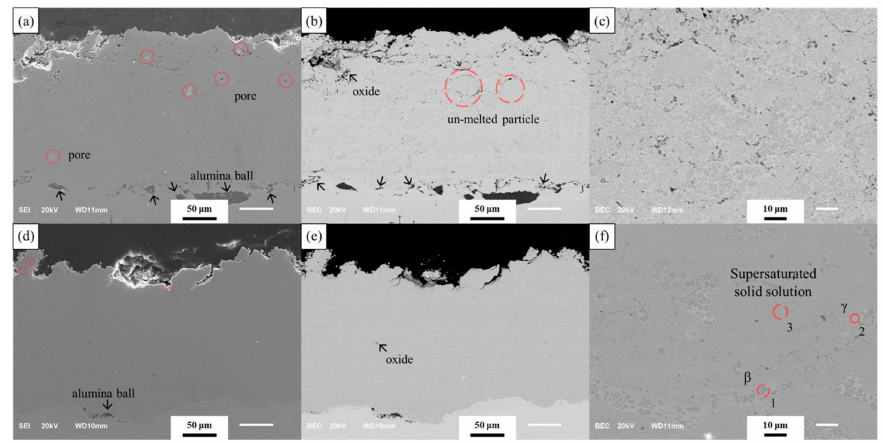
Figure 3. Microstructure analysis of as-coated HVOF ( a – c ) and VPS ( d – f ).